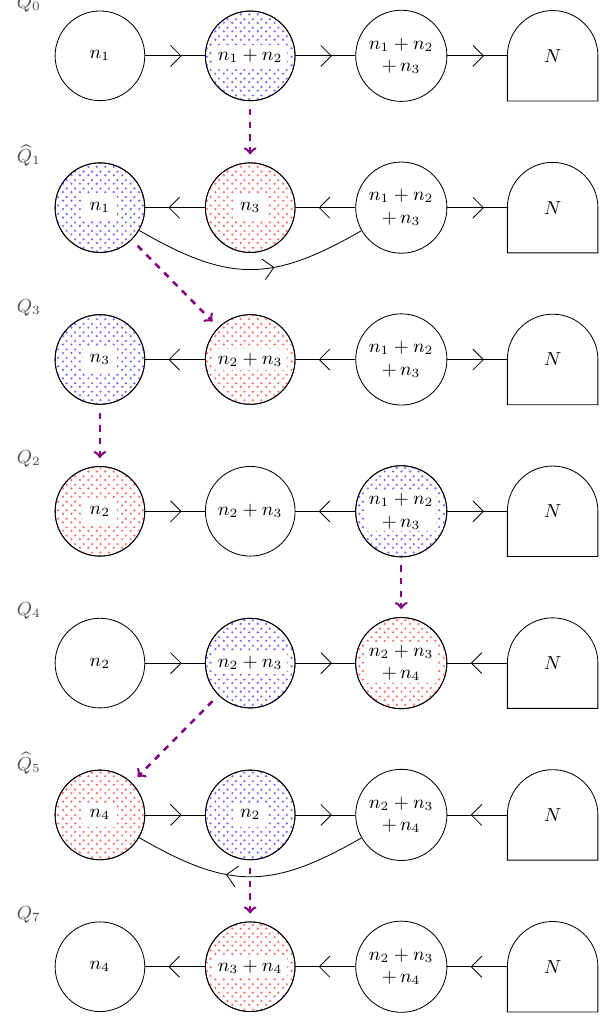
Fig. 9 Another chain of dualities to proceed from Q 0 to Q